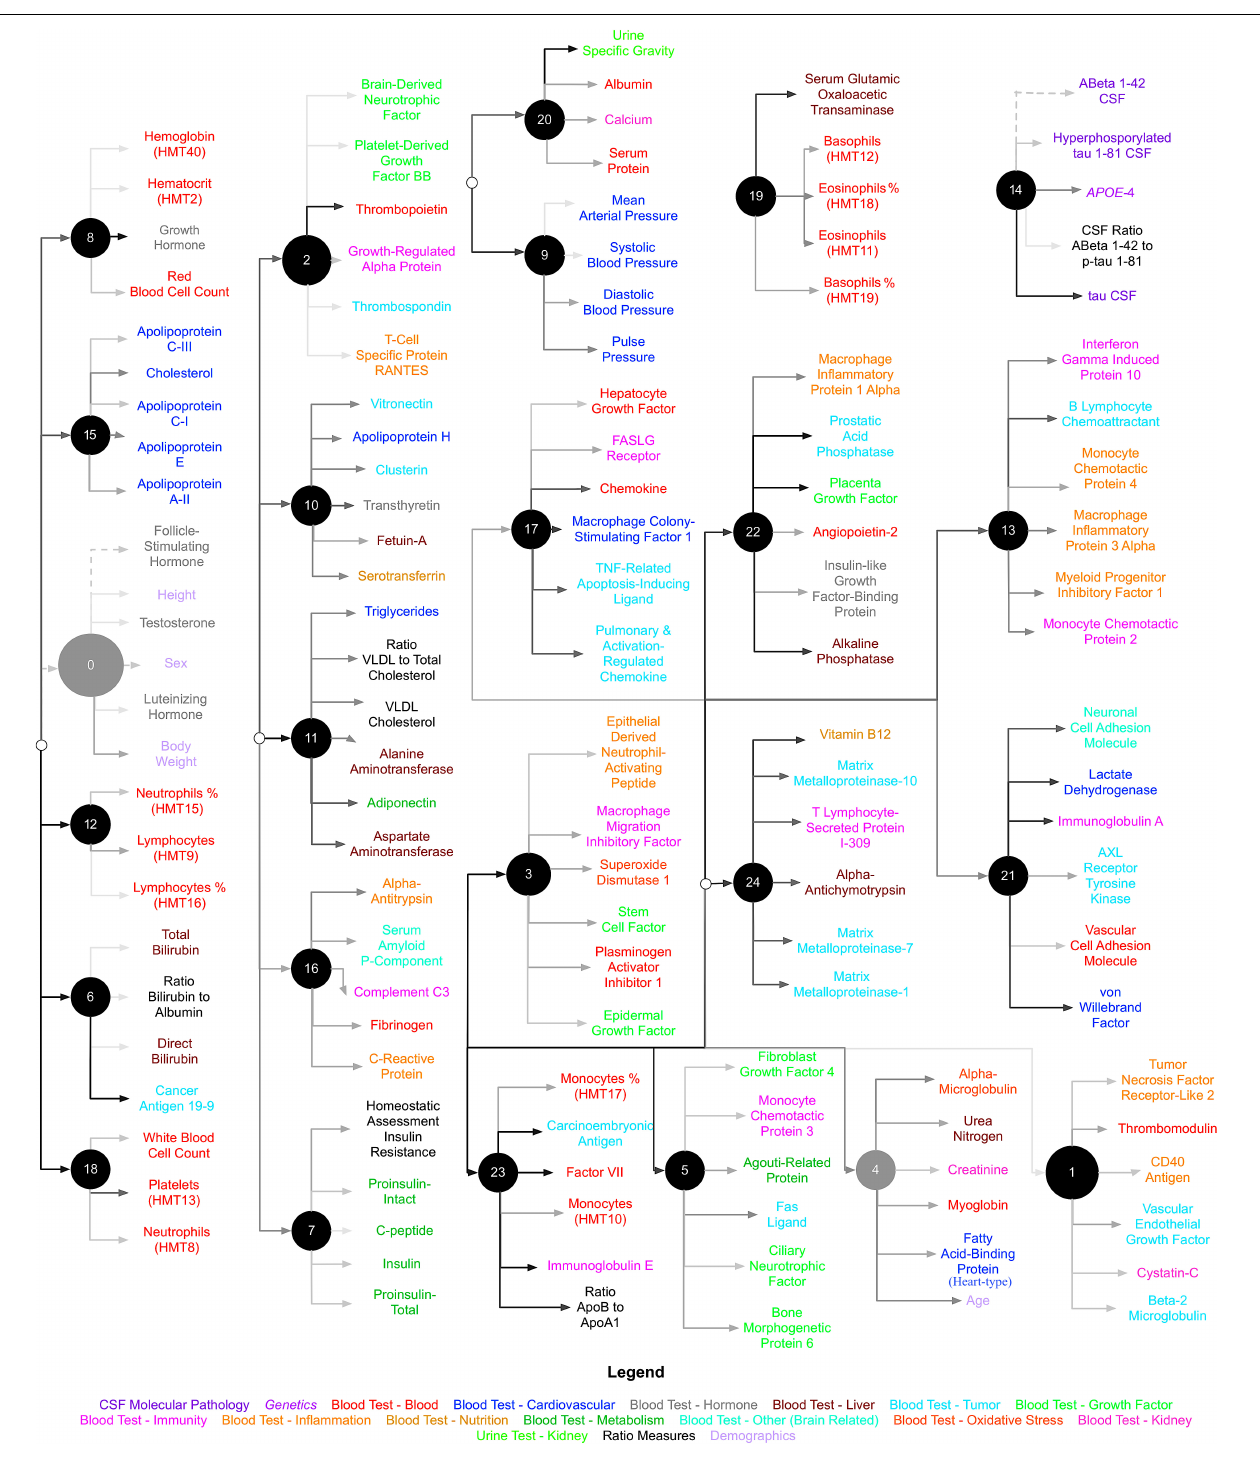
FIGURE 2 | Hierarchical representation of biomarkers constructed by CorEx. Using CorEx across a panel of > 200 markers of plasma, demographic, and CSF measures, we constructed a hierarchical network based on the joint information shared between measures. We identified 25 latent factors that represent the optimal total correlation across measures and factors. Latent factors are represented by circular nodes and numbered accordingly. Colors indicate variable type, as defined in the bottom legend, and gray shaded edges reflect the amount of mutual information shared between connecting nodes, where darker edges indicate more shared information. The size of each node is a function of the amount of mutual information shared among the connected variables.